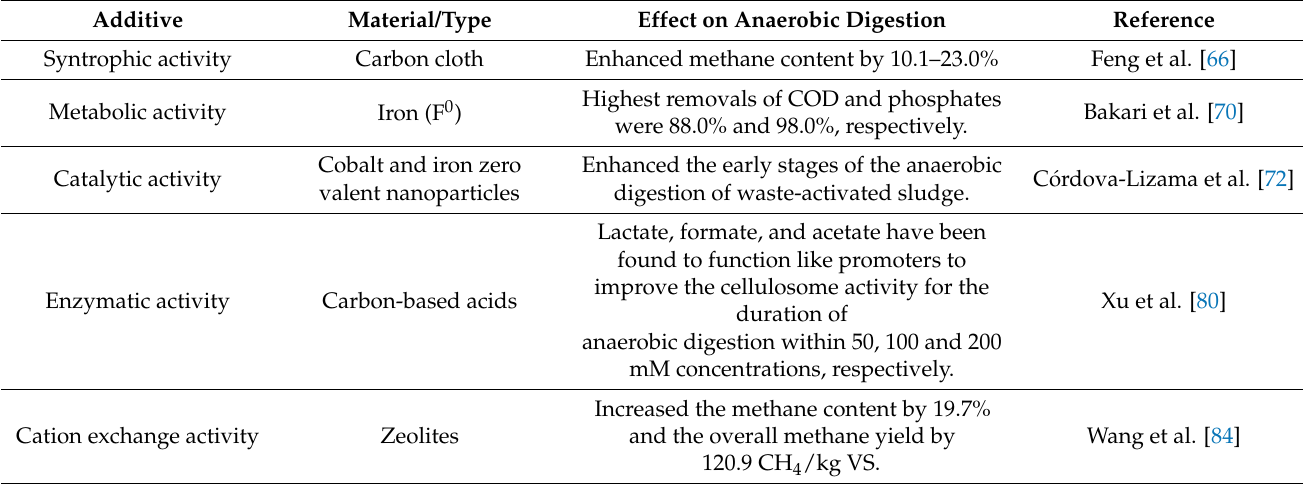
Table 3. Various additives used in anaerobic